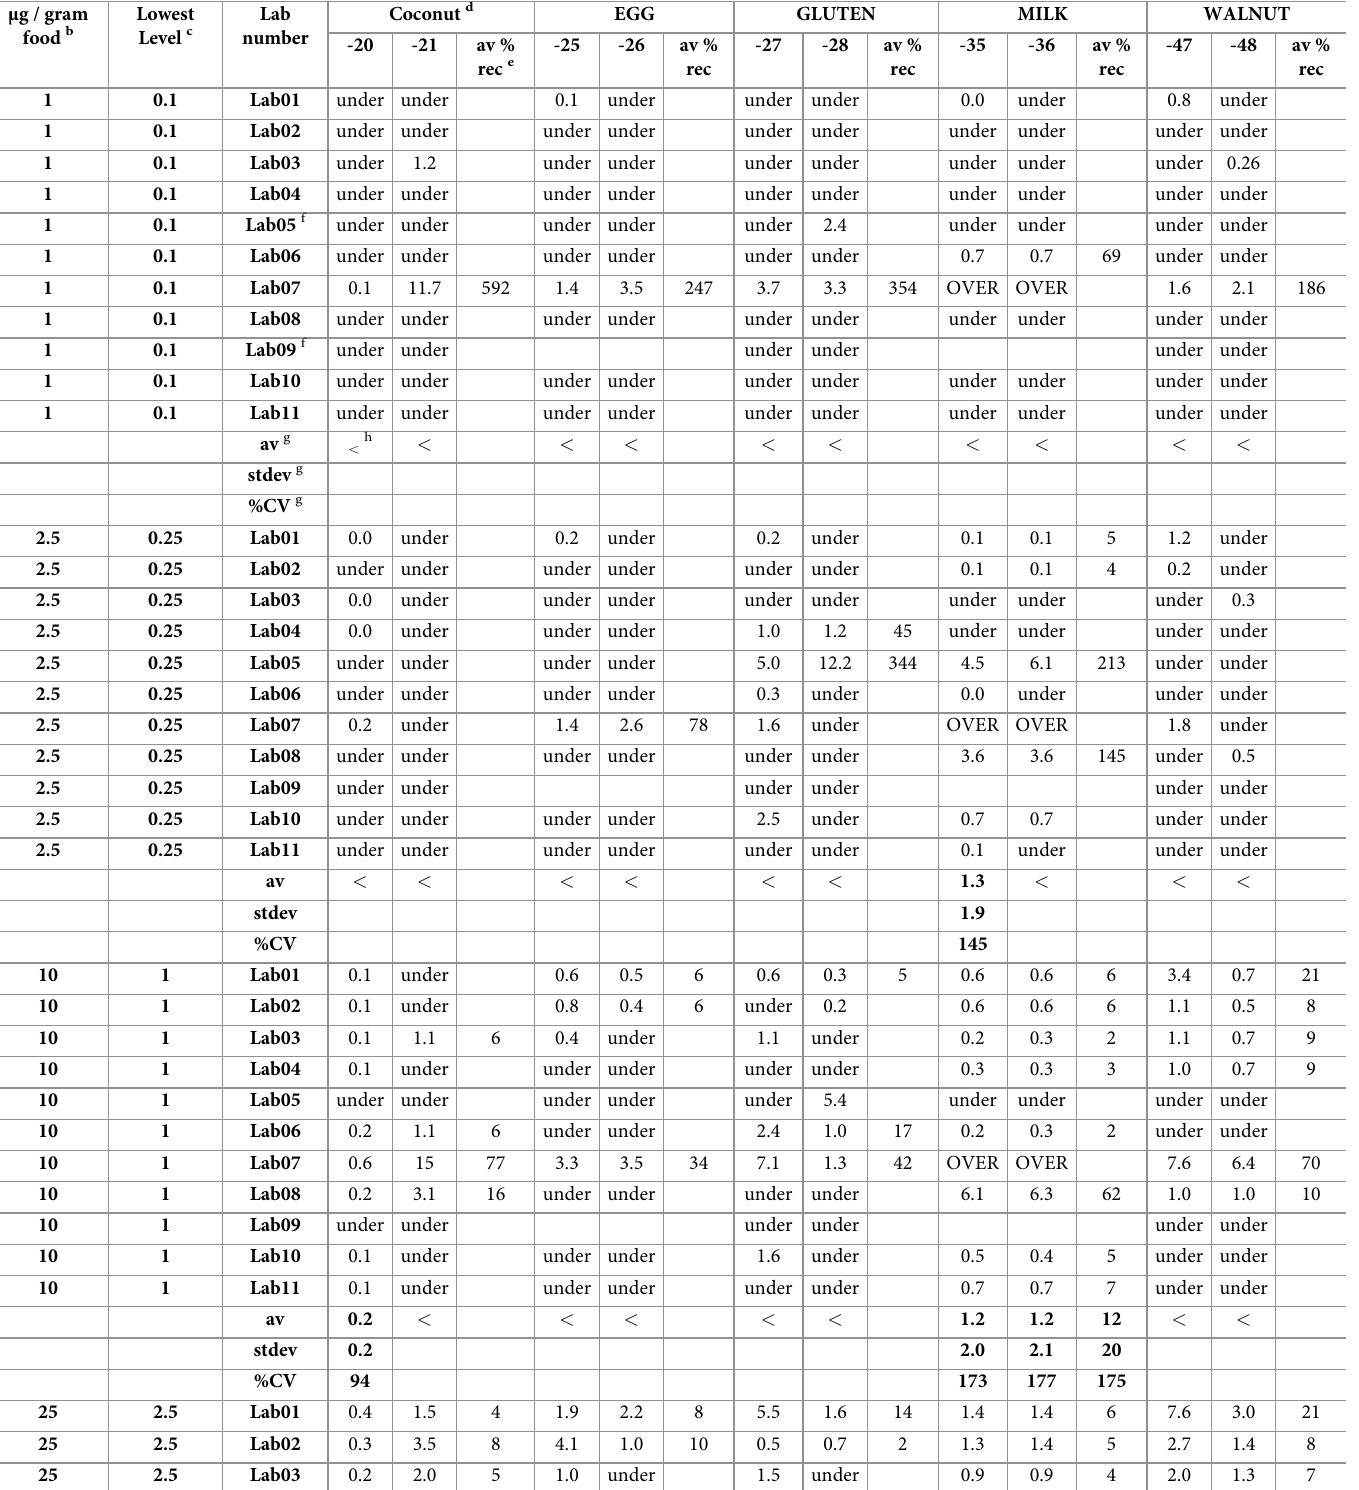
Table 14. Interpolated analyte recovered from incurred food samples: Baked muffins a . μ g / gram food